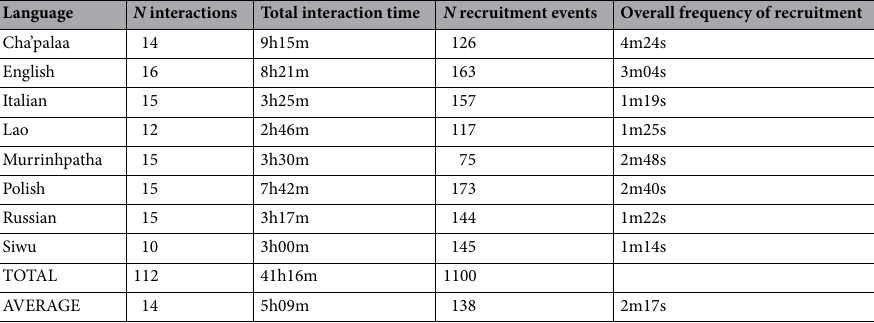
Table 1. Overall frequency of recruitment. Overall frequency of recruitment events and other characteristics of the data, including (i) the number of interactions sampled, (ii) the total interaction time sampled, and (iii) the total number of recruitment